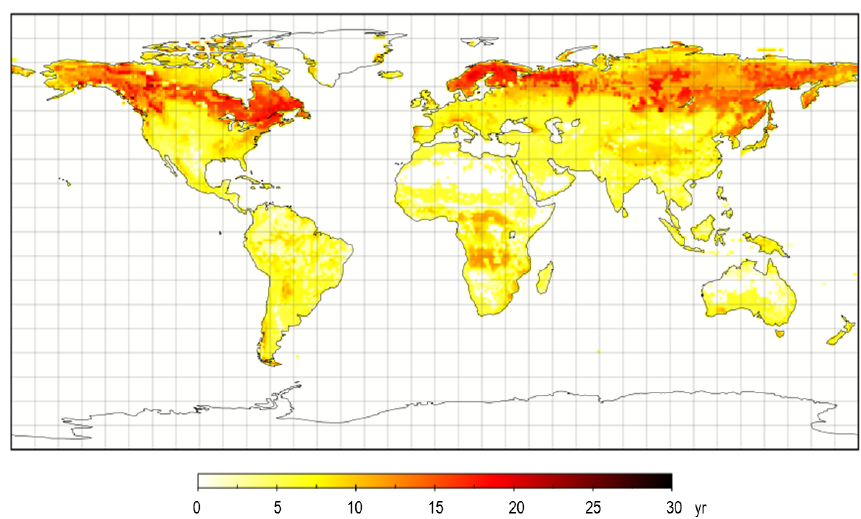
Figure 4. Global distribution of the flux-weighted mean age of soil carbon pools (Eq. 8).